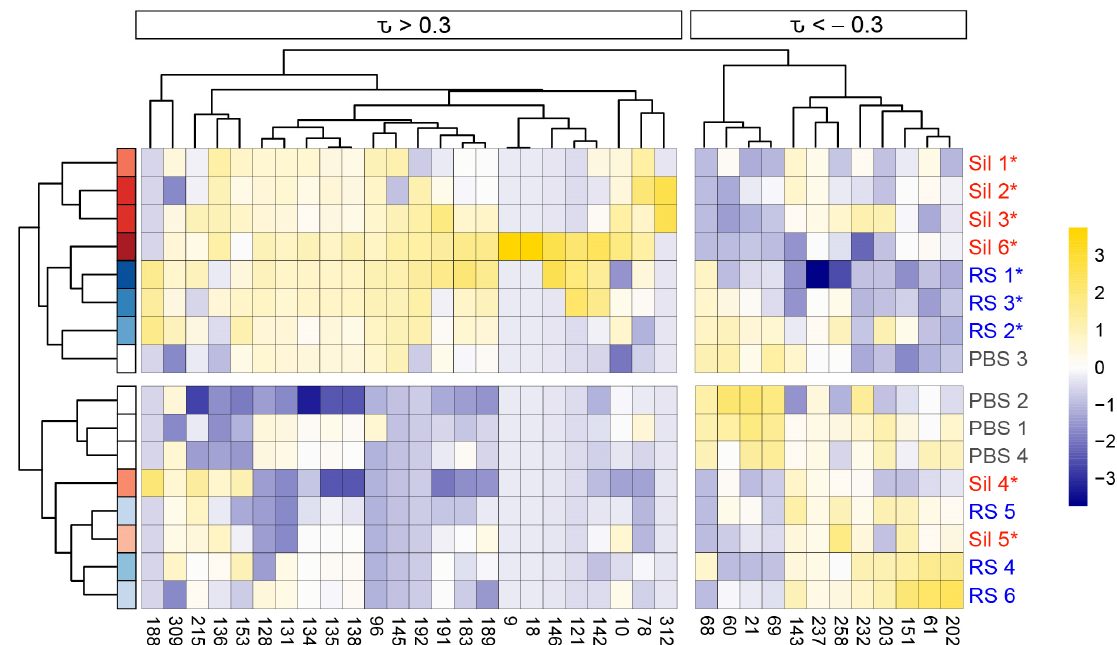
Figure 5. Immune-correlated VOCs cluster mice by total cytokine levels in BALF. Hierarchical clustering analysis (HCA) of 12 Cocci-inoculated and 4 PBS mice (rows) based on the relative abundance of 36 immune-correlated VOCs (columns) shows the mice are separated into two main clusters that reflect total BALF cytokine production. Additionally, the VOCs are divided into two clusters, those that are positively correlated ( τ > 0.3) with cytokine production and those that are negatively correlated ( τ <–0.3). Clustering of mice and VOCs used Pearson correlations with average linkage. Mice are color-coded by strain (blue = C. immitis RS; red = C. posadasii Sil) and a color gradient indicating total cytokine abundance, with darker color meaning higher abundance; disseminated disease is indicated with an asterisk (fungal counts in the spleen and brain are provided in Supplementary Table S2). Kendall correlation between volatiles and cytokines is noted above the dendrogram, with τ > 0.3 for positive correlations and τ < − 0.3 for negative. Volatiles abundances (mean-centered and scaled to unit variance) are represented in the heat map. Additional information about the VOCs, including putative identities, is provided in Supplementary Table S3.